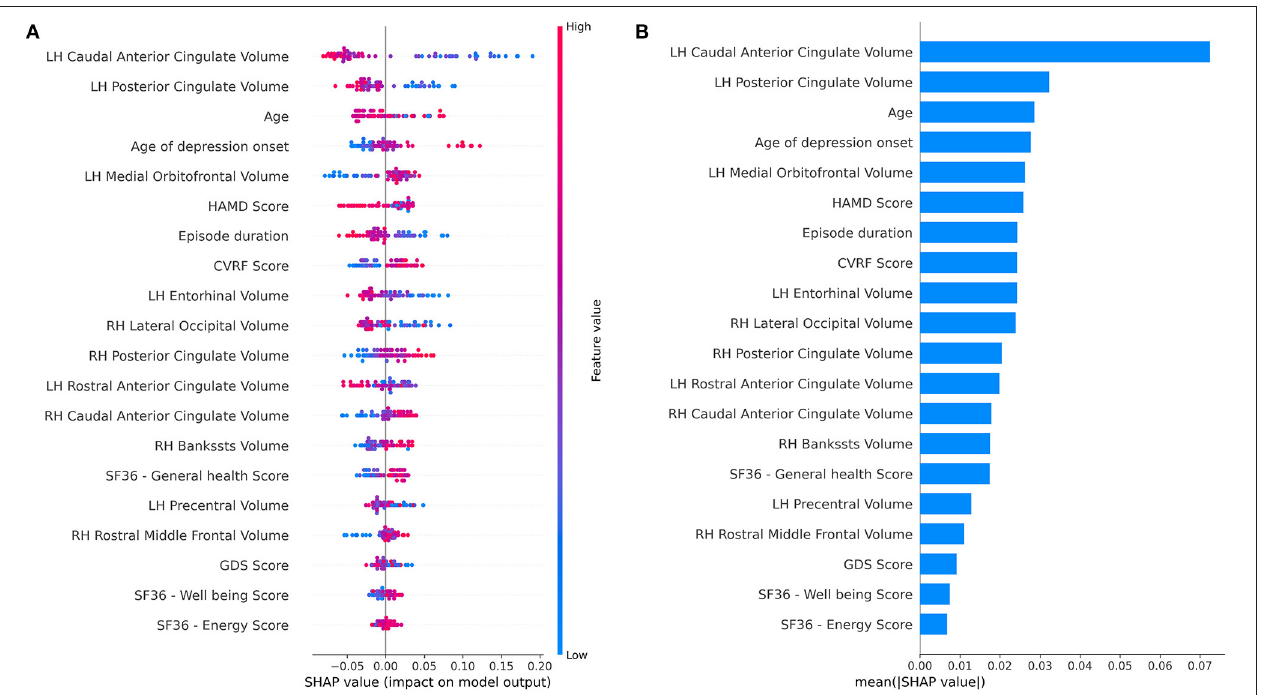
FIGURE 3 | Feature importance summary of random forest classifier using the combined feature set. (A) SHAP (SHapley Additive exPlanation) values are ordered by value of a feature to the predictions made by the classifier. The position on the x-axis on shows whether the effect of that value is associated with a higher or lower prediction for a given observation. Red color indicates the feature is high for that observation or low (blue). (B) Summary of mean SHAP values or overall magnitude of a feature’s impact on prediction of depressive